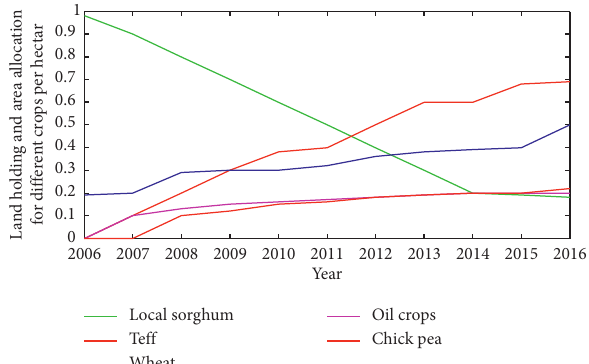
Figure 4: Trends in landholding and area allocation for different crops in 10 or 11 years for all surveyed areas. Source: Woreda Agricultural and Rural Development Offices, during the survey period, 2015/2016.